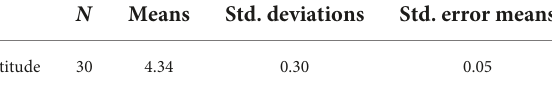
TABLE 6 Descriptive statistics for experimental participants’ attitudes scores.